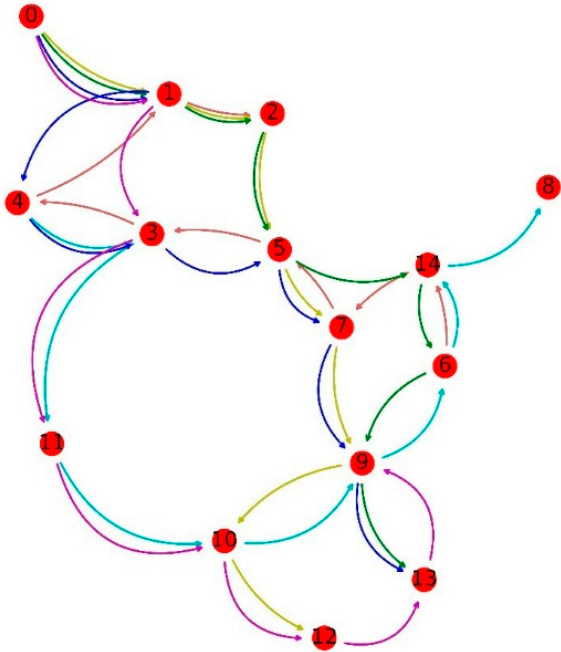
Table 4. Best Route Set for 6-Route Case.